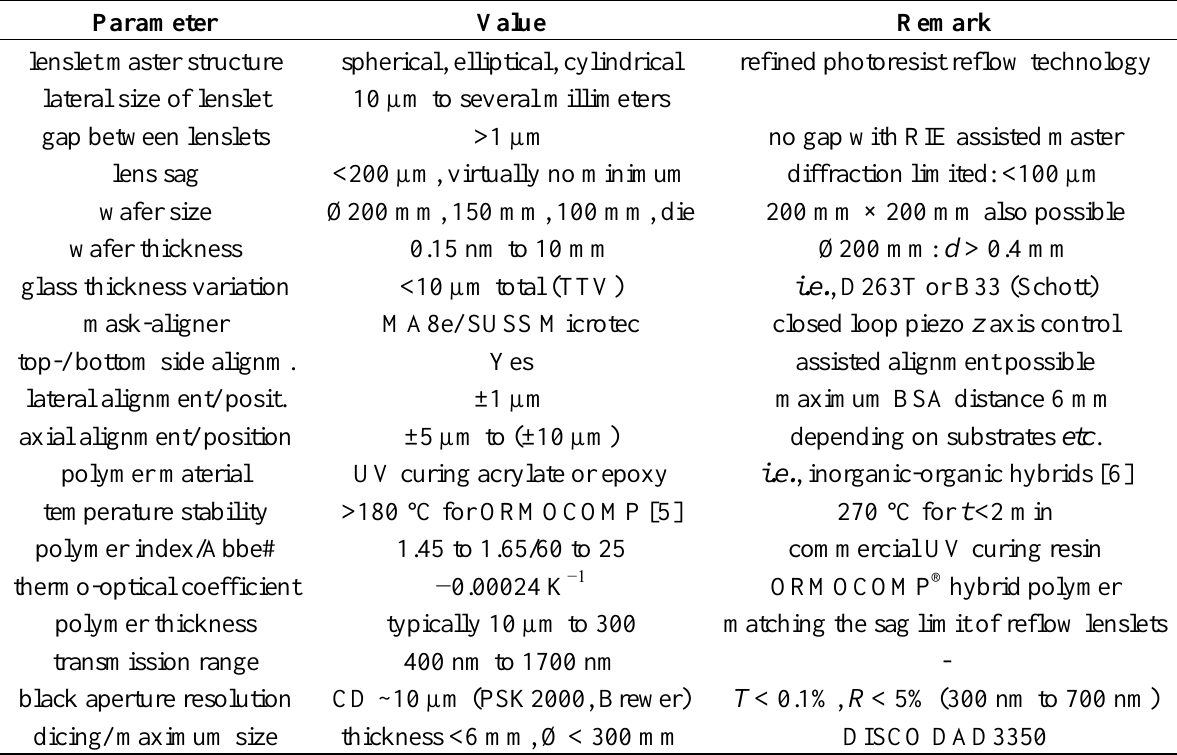
Table 1. Summary of essential technology parameters and typical values